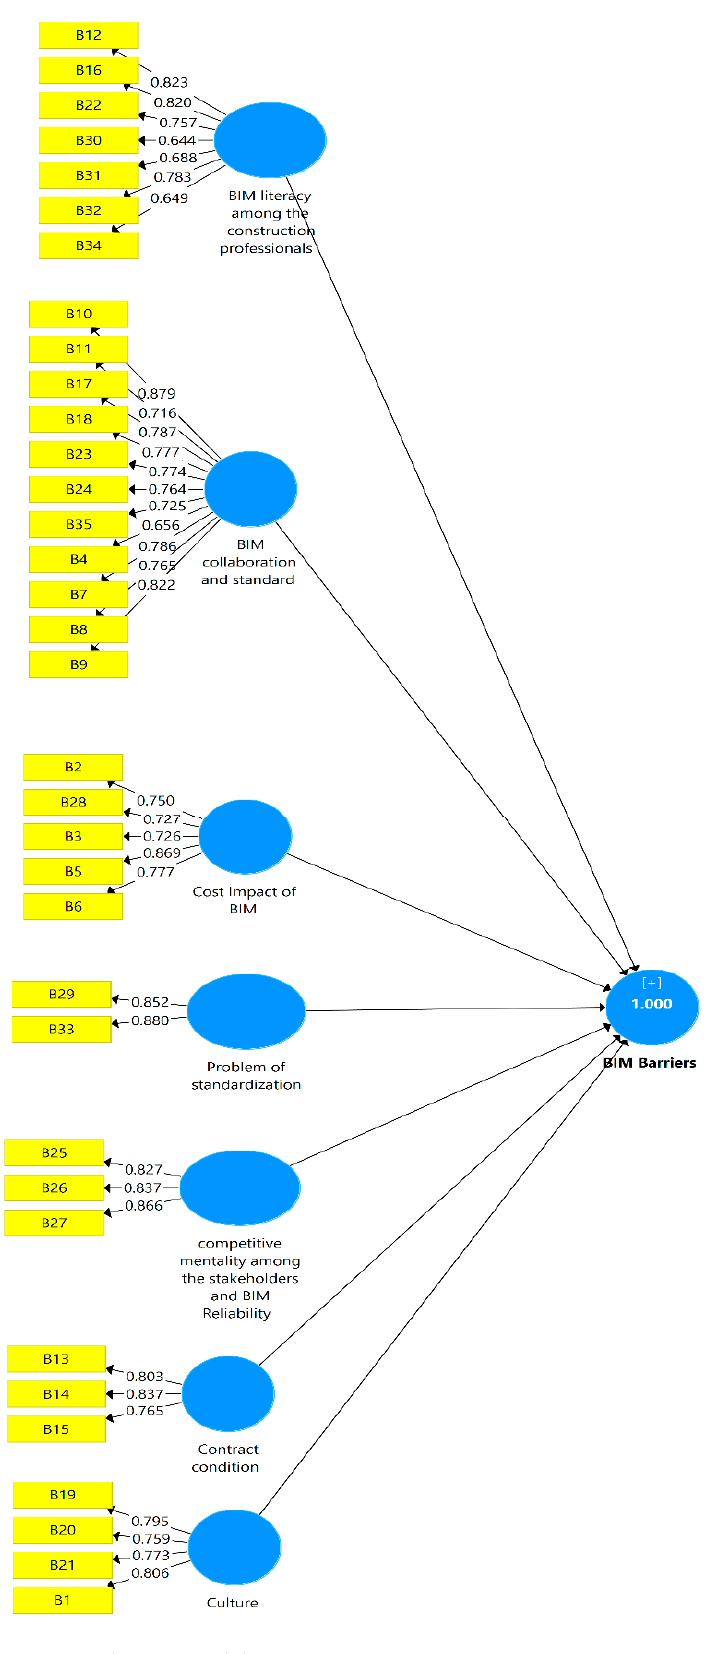
Figure 2. The PLS